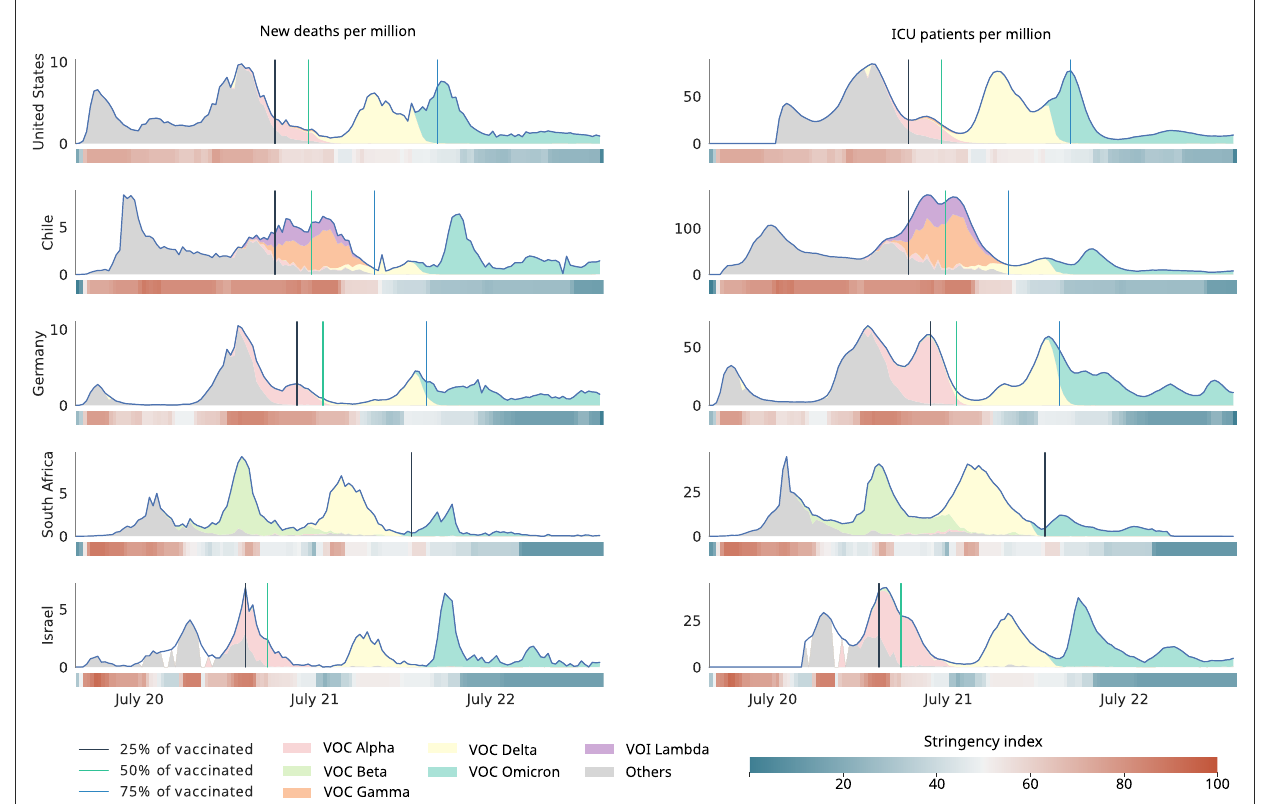
FIGURE1 Behavior of epidemiological variables during the ongoing pandemic of COVID-19. The figure depicts the timeline of new deaths per million inhabitants (left) and admissions to intensive care unit (ICU) per million inhabitants (right) in relationship with SARS-CoV-2 variants, vaccination thresholds, and non-pharmacological interventions. The stringency index is a composite measure based on nine response indicators including school closures, workplace closures, and travel bans, rescaled to a value from 0 to 100 (100 = strictest). Data acquired from et al. (27), Hasell et al. (28), and Khare et al.